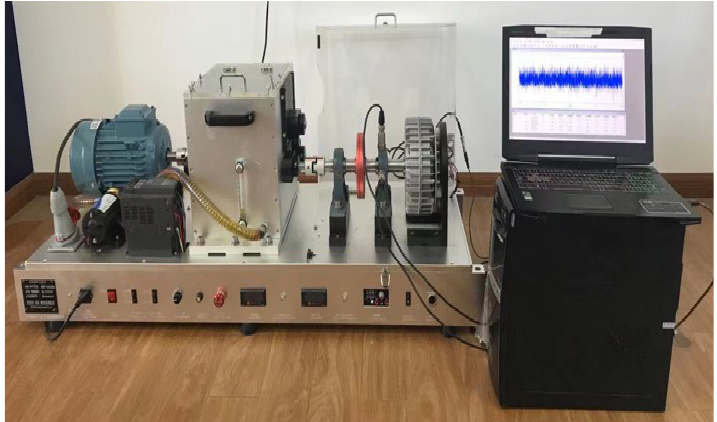
Figure 5. Experimental platform.